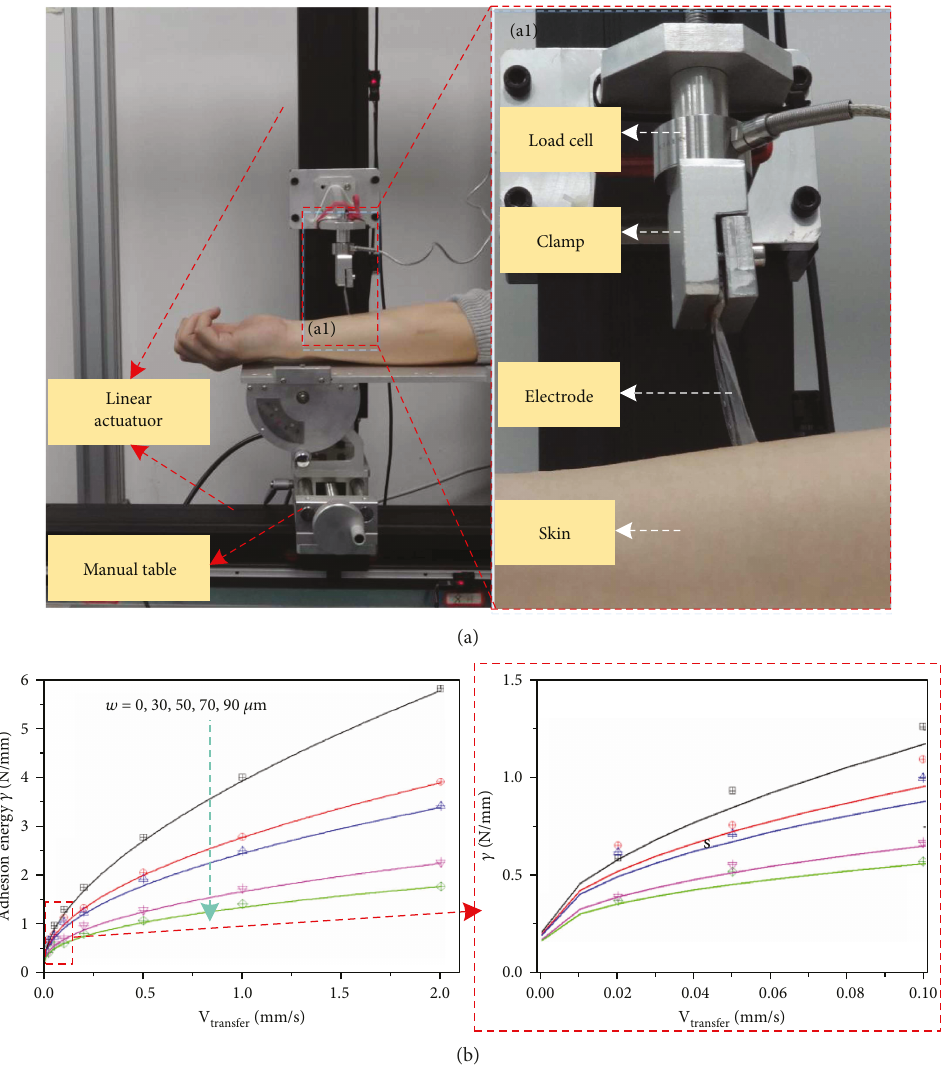
Figure 8: (a) The peeling test experiment platform and the local enlarged graph and (b) experiment data and analysis from the experiment platform at skin-electrode interface with di ff erent line